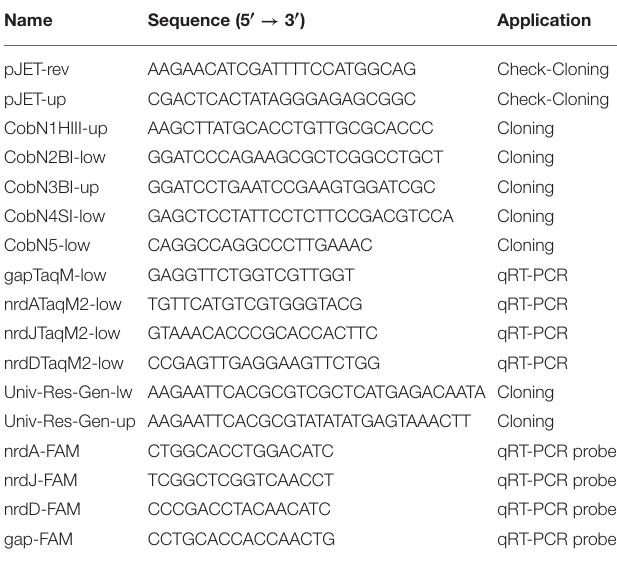
TABLE 2 | Oligonucleotides and probes used in this